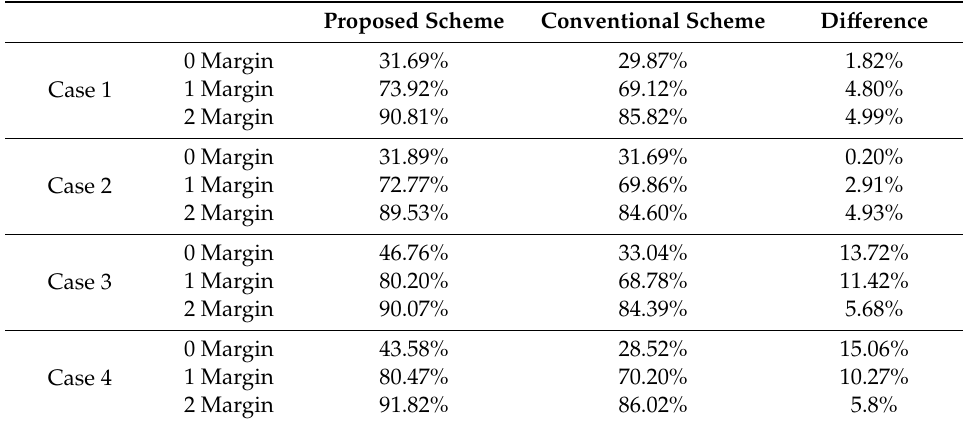
Table 7. Average